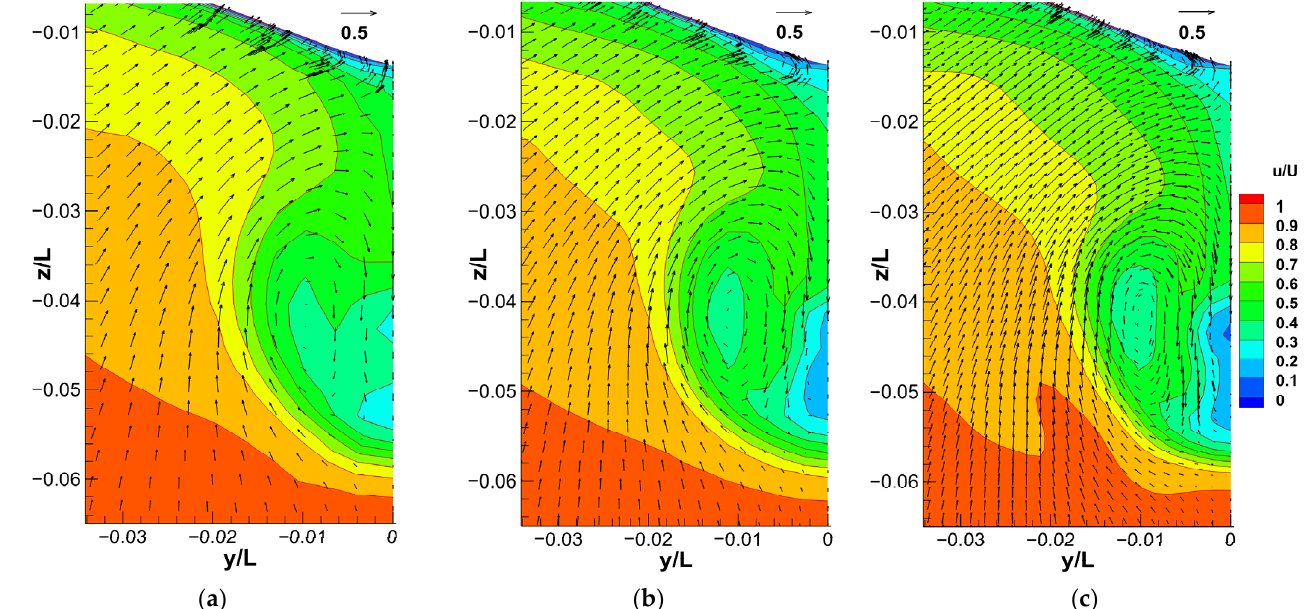
Figure 10. CFD nominal wake velocity field without duct: ( a ) coarse; ( b ) medium; and ( c ) fine grid.